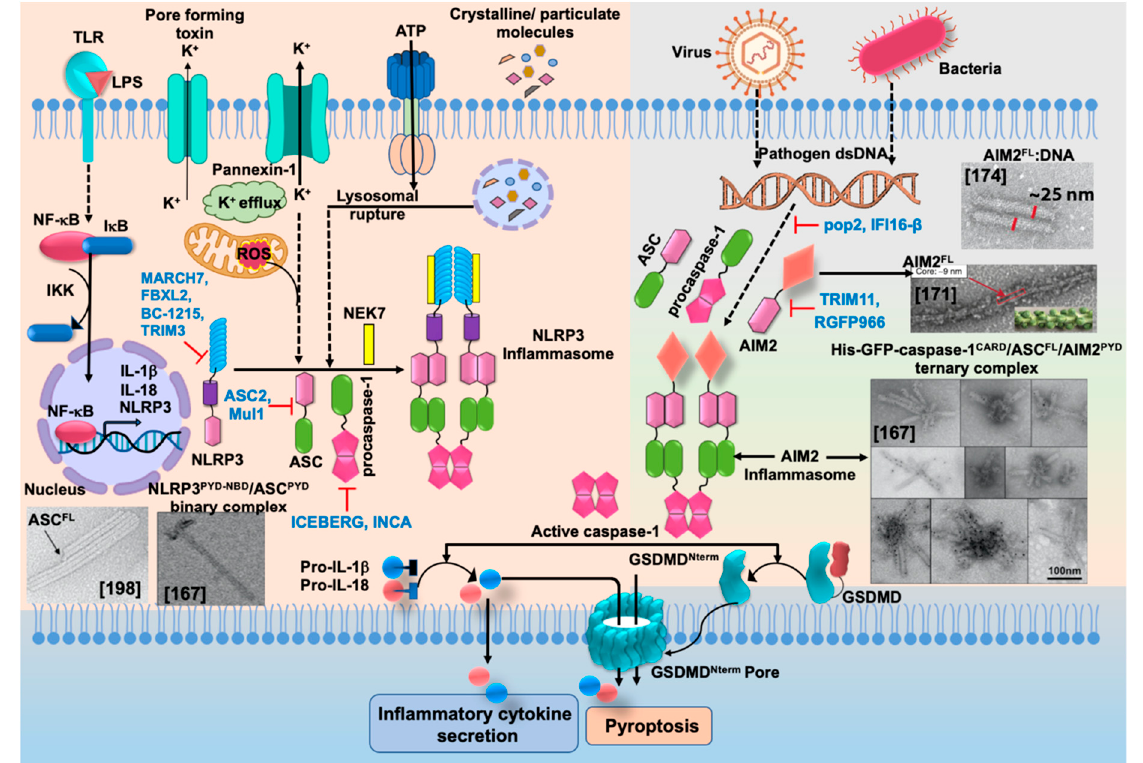
Figure 6. Schematic representation of NLRP3 and AIM2 inflammasomes activation and assembly. Pathogen-associated molecular patterns such as LPS, crystalline/particulate ligands, K + efflux, and ROS trigger the activation of NLRP3. TLR initiates the activation and nuclear translocation of NF- κ B, which increases the synthesis of NLRP3 and IL-1 β and IL-18 cytokines. AIM2 detects viral and bacterial dsDNA in the cytosol. Assembly of NLRP3 or AIM2 with ASC and procaspase-1 leads to the proximity-induced autoproteolytic maturation of caspase-1, functionalization of IL-1 β and IL-18, and pyroptosis cell death mediated by the N-terminal fragment of gasdermin D. Inhibitors of NLRP3, ASC, caspase-1, and AIM2 are shown blue. The reference sources corresponding to the negative-staining electron micrographs are shown in square brackets in each image: ASC FL adapted from Figure 6 of [198], filamentous NLRP3 PYD-NBD -ASC PYD binary complex adapted from Figure 2 of [167]; filament of AIM2 FL from Figure 6 of [171], AIM2 FL filament with 600 bp dsDNA adapted from Figure 3 (Copyright National Academy of Science) of [174], and His-GFP-caspase-1 CARD /ASC FL /AIM2 PYD ternary complex adapted from Figure 6 [167].